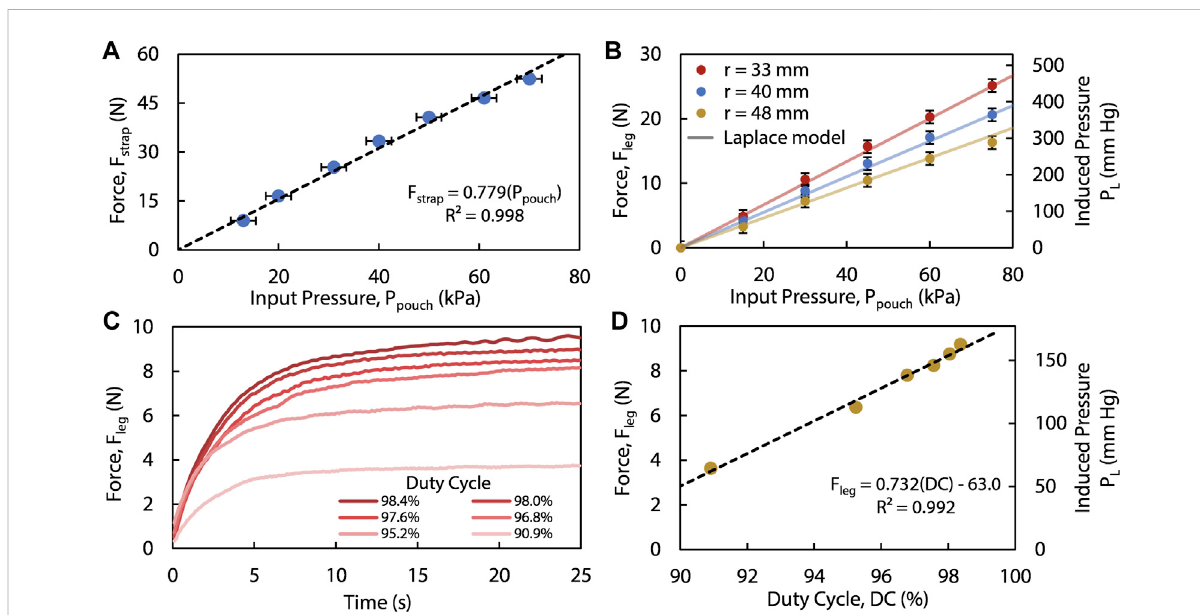
FIGURE 3 P (A) The linear force( F strap )ofeachstrapatdifferentinput pressures ( pouch ),which ismodeledlinearly within ouroperationalrange ofpressures. The error bars in (A) are fi xed at 2.5 kpa, which is the experimentally observed fl uctuation of our supplied pressure, measured by the pressure gauge duringthecontractileforcetestingintheuniversaltestingmachine.Theerrorbarsin (B) are fi xedat1 N,whichistheerrorrangeoftheforcesensor ’ s raw data that we averaged to obtain the fi nal single data point. (B) The force on the leg ( F leg ) at radius, r , is measured, equated to the induced Laplacepressure(